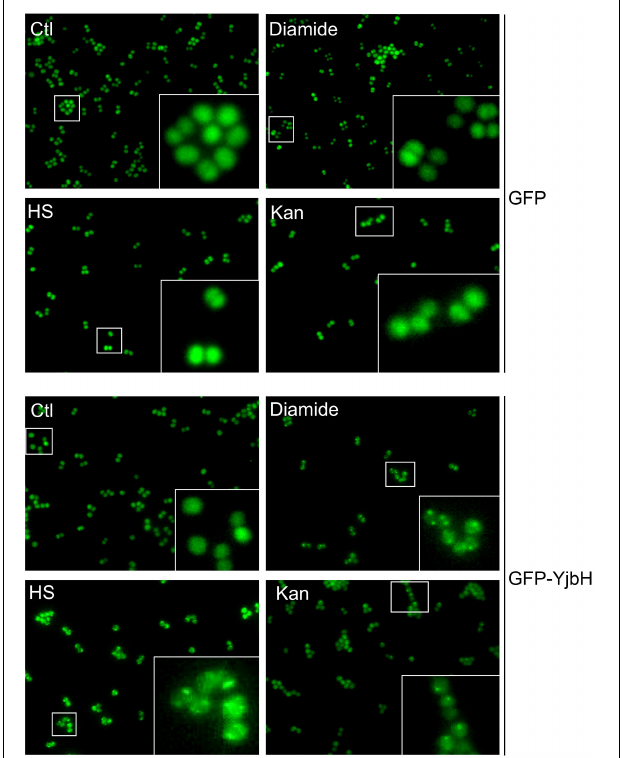
FIGURE 2 | sfGFP-YjbH is accumulated in foci upon heat shock, oxidative stress, and antibiotic treatment. Cells, expressing sfGFP-YjbH were not treated (Ctl), or treated with high temperature (53 ◦ C, HS), 5 mM of diamide or 400 µ g/ml of ribosome-targeting antibiotic, kanamycin (Kan) and analyzed by fluorescence microscopy (lower panel, GFP-YjbH). Cells, expressing only sfGFP were used as a control and treated in the same manner (upper panel,